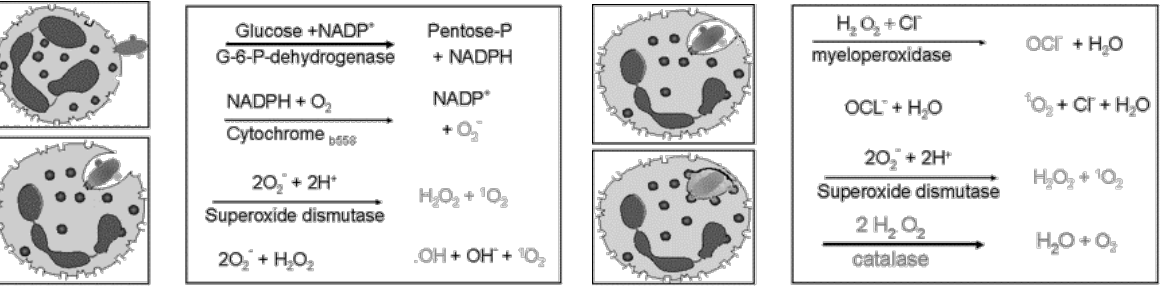
FIGURE 1. Reactive oxygen and nitrogen species generation through phagocyte respiratory burst.